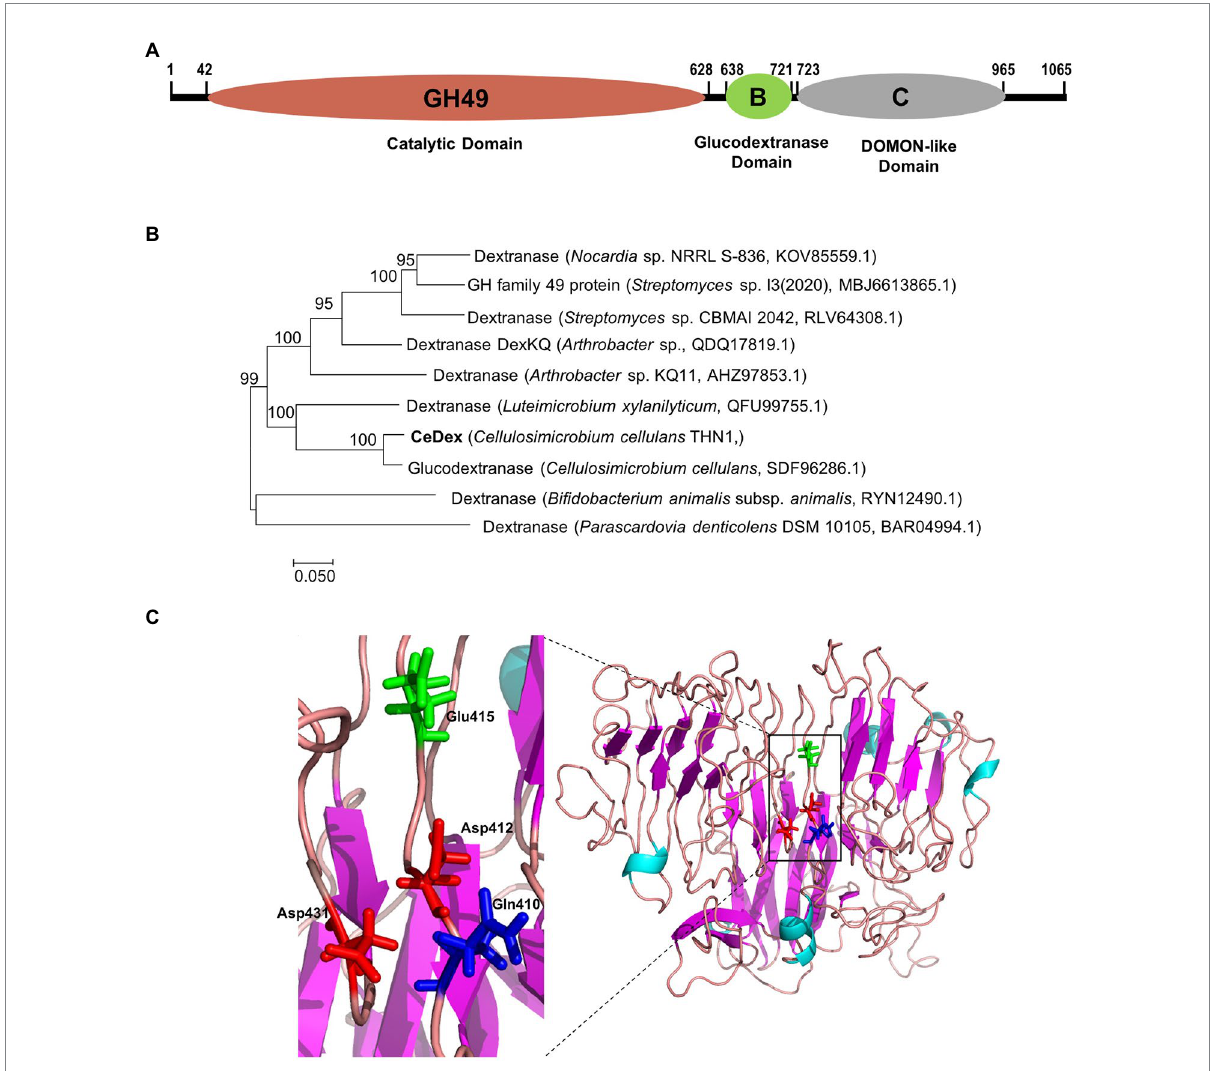
FIGURE 6 Sequence and three-dimensional structure analysis of CeDex2365. (A) Conserved domains analysis using the Conserved Domain Database (Lu et al., 2020). (B) Phylogenetic analysis of the GH49 domain of CeDex2365. (C) 3D structure of the GH49 domain of CeDex2365. Amino acid residues corresponding to catalysis are presented in the